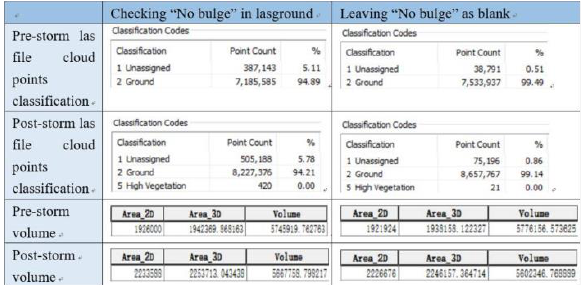
Figure 11. Different results in LASground tool by applying “no